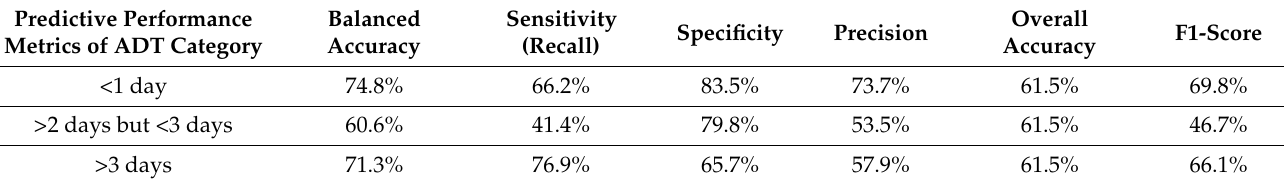
Table 8. Summary of the predictive performance results of BN model developed to model ADT. Predictive